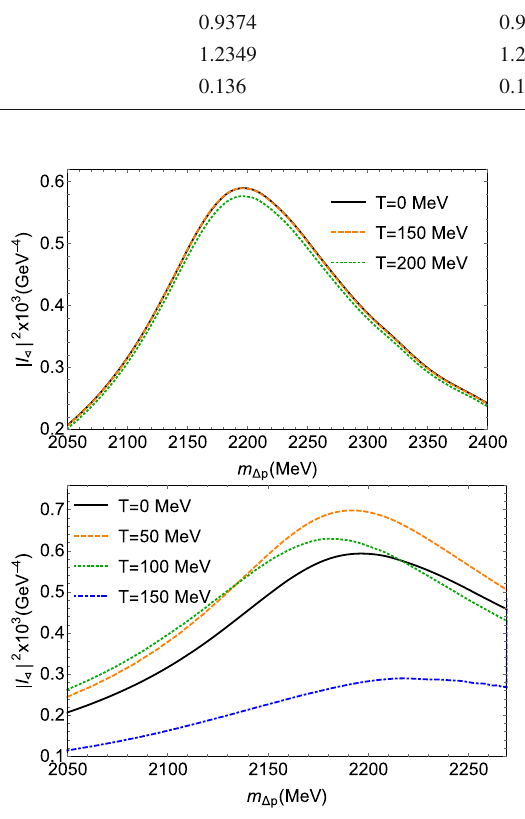
Fig. 8 Spectrumof Δ p intheregioncorrespondingtothepresumed d ∗ resonance. If the triangle mechanism of Fig. 7 is behind the apparently resonant cross-section, a thermal bath will significantly damp it for temperatures above 100 MeV: the difference between the top (with vacuum particle properties) and bottom (with thermal properties) plots shows once more that it is very important to know the behavior of the particle poles in the medium, as they provide the dominant effect